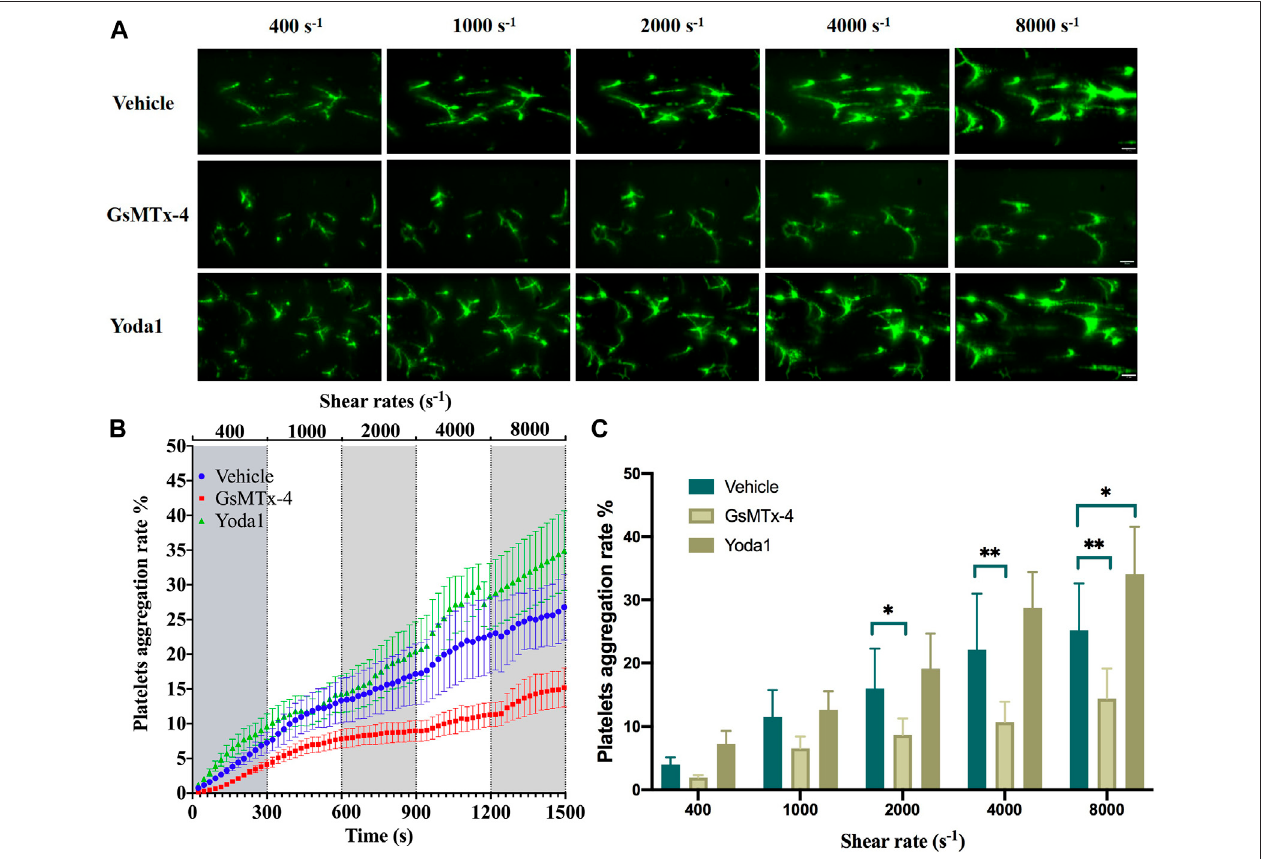
FIGURE 2| Role of the Piezo1 channel in shear-induced platelet aggregation. (A) Representative images showing effects oftreatment with GsMTx-4 (2.5 µM) and Yoda1 (25 µM) on platelet aggregation under shear rates of400, 1,000, 2,000, 4,000 and 8,000 s − 1 . The scale bar is50 µm. (B) Mean time-course ofplate aggregation fromthreeindependentexperimentsundertheconditionsshownin (A) . (C) Meanplateletaggregationrateattheendofexposuretoindicatedshearrates.* p < 0.05and ** p < 0.01, analyzed by two-way ANOVA and post-hoc Tukey ’ s test.